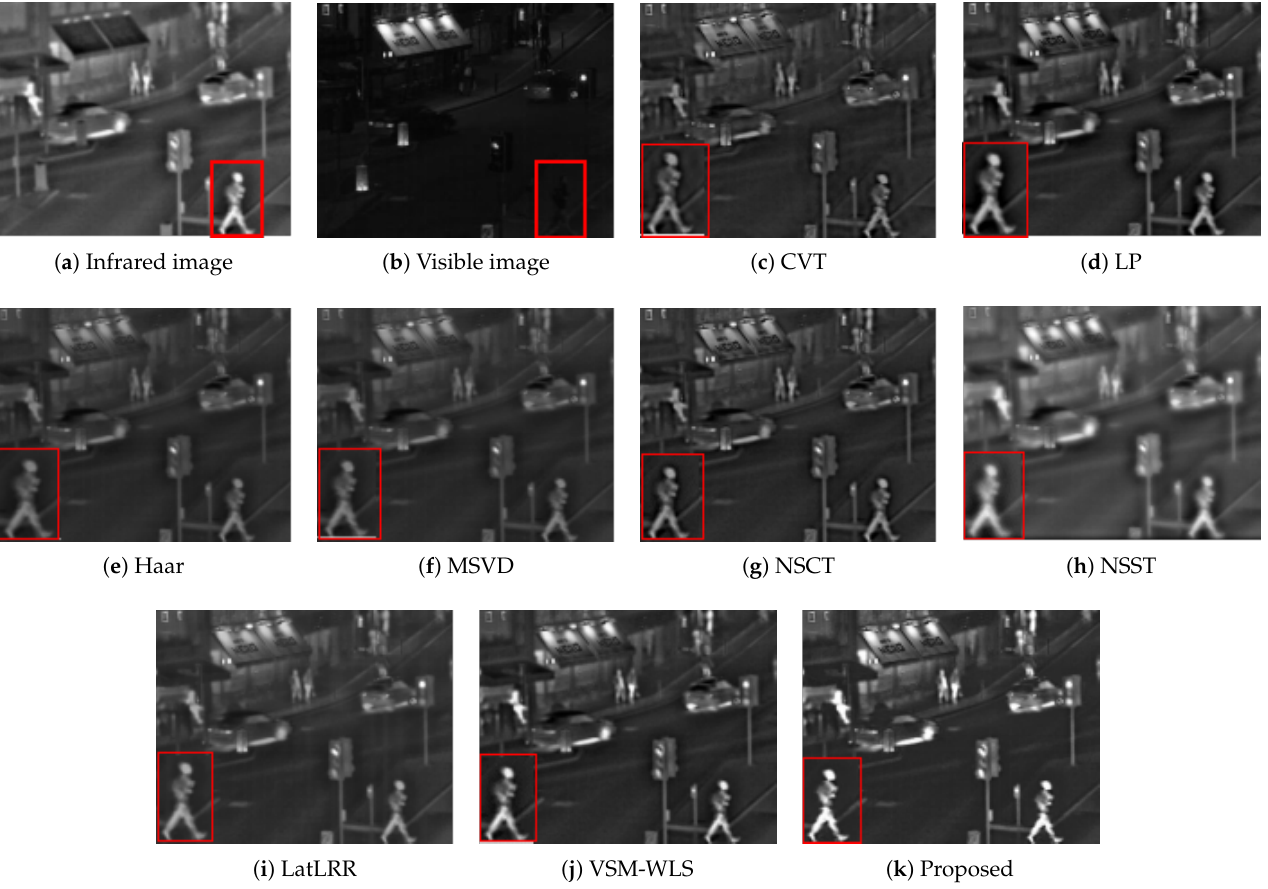
Figure 8. Image fusion results of the first group. The red box in the first two images is the main contrast area, and the red box in the remaining images is the enlarged effect of the contrast